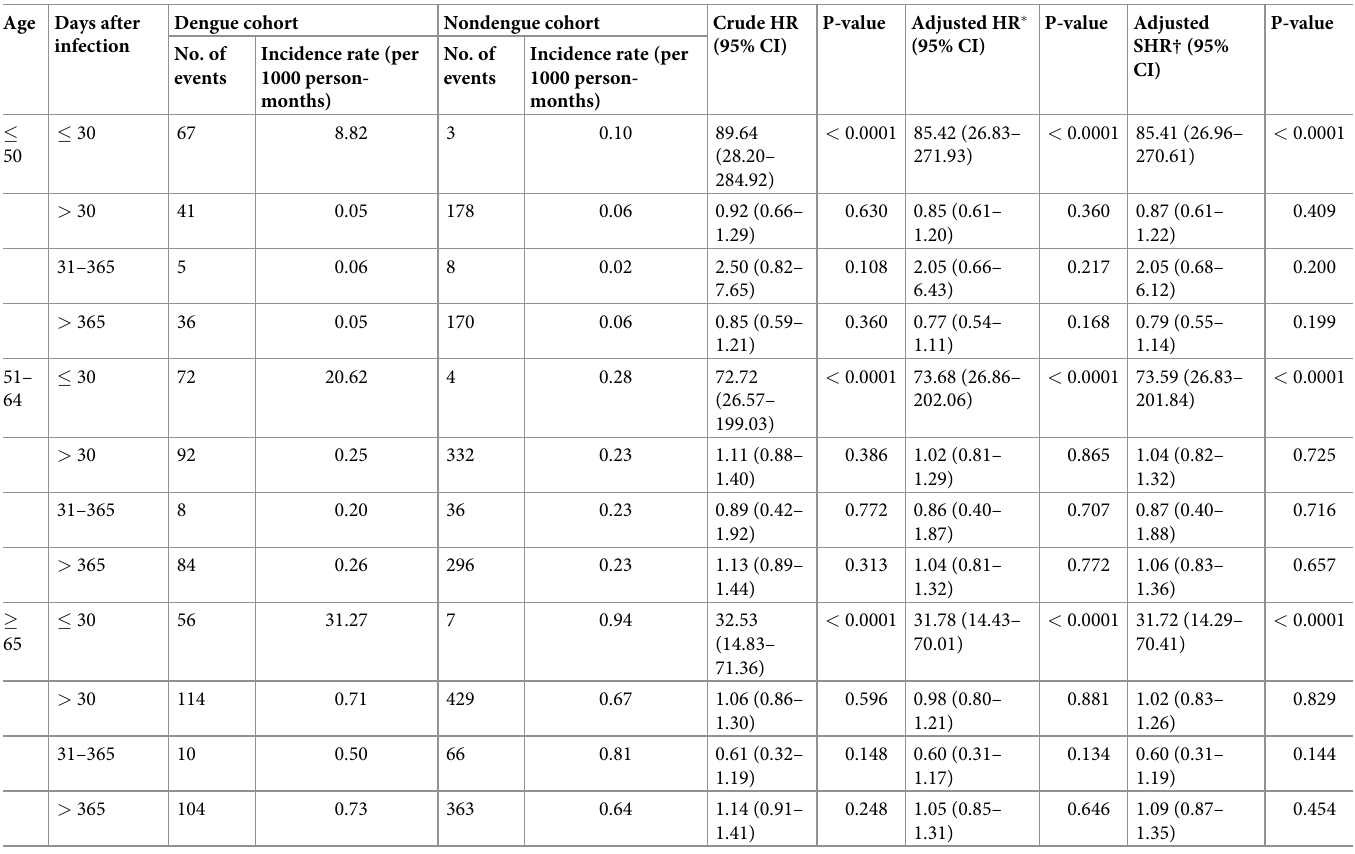
Table 3. Comparison of the incidence of nonvariceal upper GI bleeding (stratified by